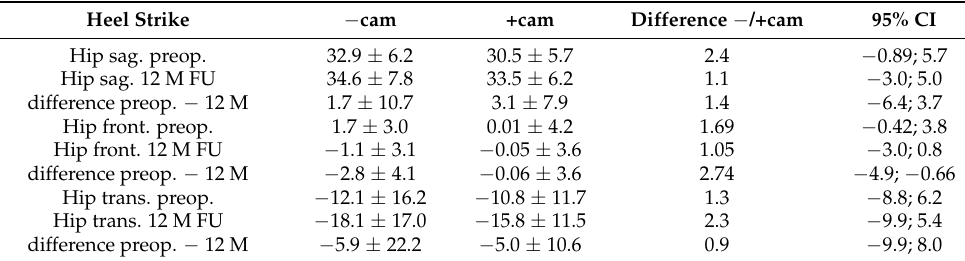
Table 2. Mean values and standard deviation at the heel strike of the treated hip before and 12 months after surgery dependent on a cam shaped femoral neck junction. The difference in the frontal plane was statistically significant with a lower reduction to the adduction after treatment in patients with an FAI type cam. The mean differences between the hip angles in presence of a cam deformity and absence ranged between 0.9–2.7°. Heel Strike − cam